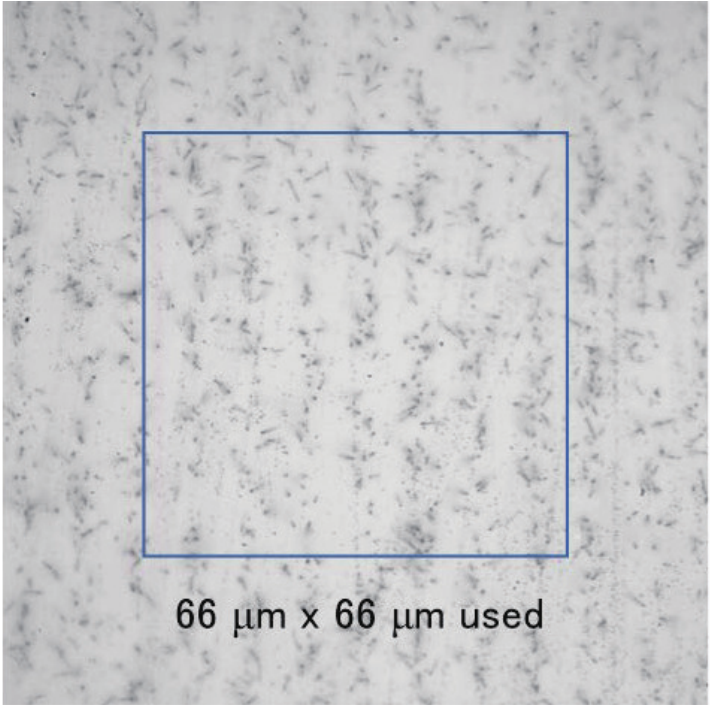
Figure 4. Expansion of the neutron transmission image of the Gd